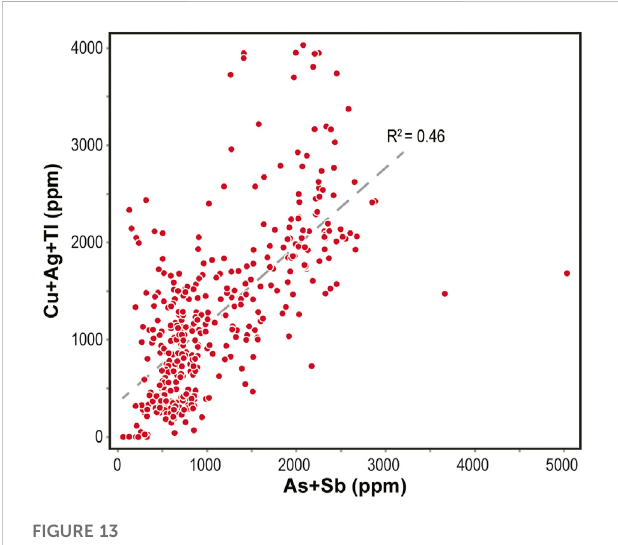
FIGURE 13 A bivariate plot of As+Sb (in ppm) and Cu+Ag+Tl (in ppm) for all analyses of Py-1.